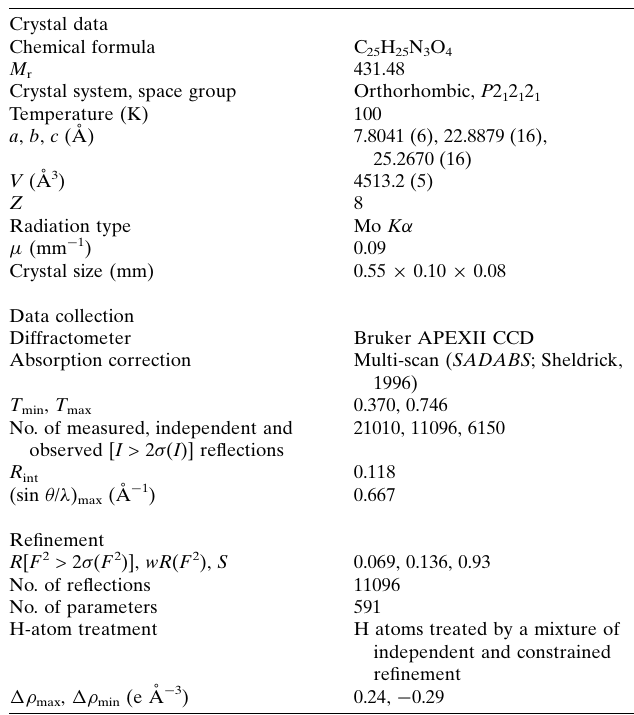
Table 1 Hydrogen-bond geometry (A˚ , (cid:3) ).